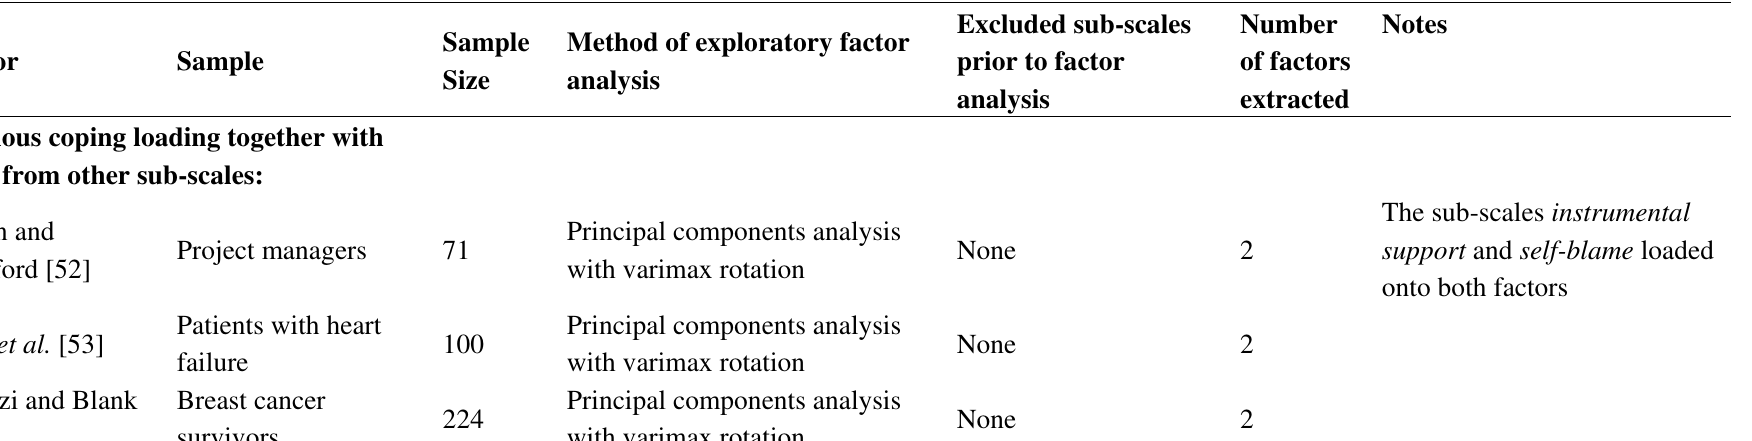
Table 2. Summary of studies identified in the systematic review that had conducted a sub-scale-level factor analysis on their own dataset. Listed are the type of sample, the sample size, the method of factor analysis used, and whether items had been excluded from the factor analysis. The number of factors extracted is also listed for each study. Unless otherwise stated in the notes, an English language version of the Brief COPE [1] was